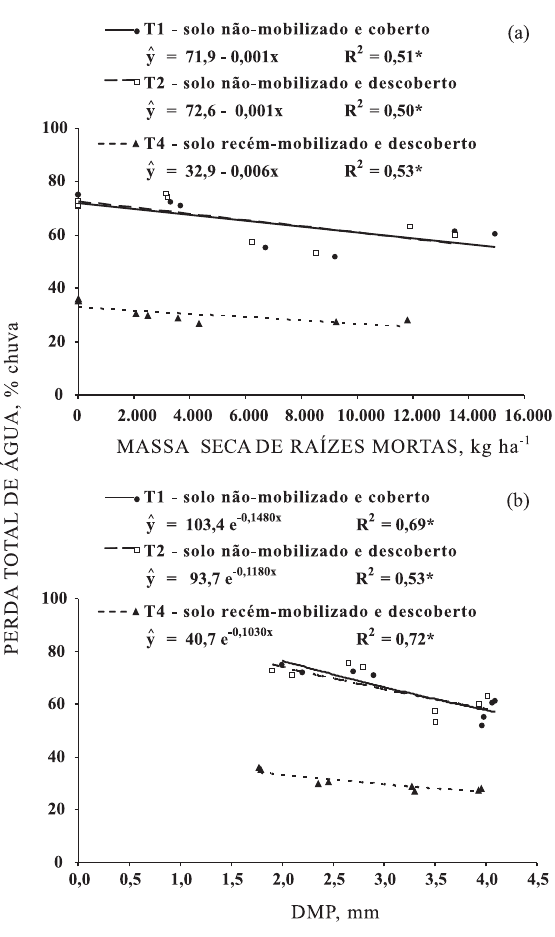
Figura 5. Relação da perda total de solo com a massa seca de raízes mortas (a) e com o diâmetro médio ponderado – DMP - de agregados (b) na camada de 0 a 10 cm, em distintas condições físicas da camada superficial do solo, independentemente das seqüências culturais